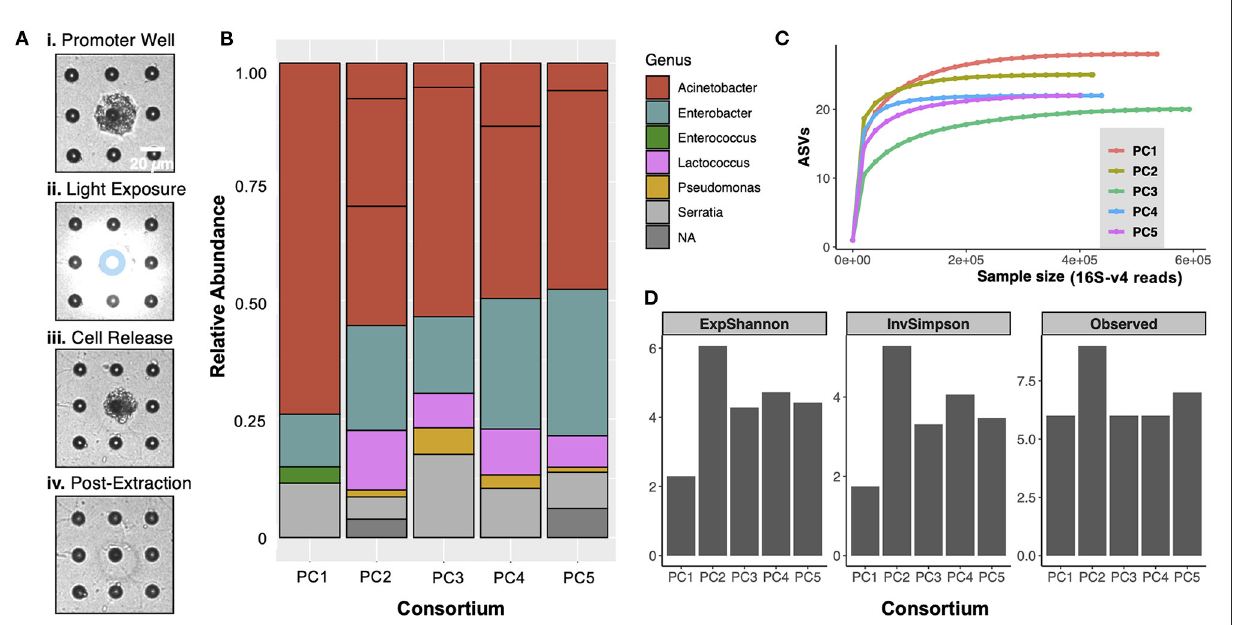
FIGURE3 (A) Removal of communities from promoter wells. The perimeter of the promoter well was exposed to UV light in a 10 µ m inner diameter and 20 µ m outer diameter ring pattern (denoted by blue ring in (ii)) to open the photodegradable membrane above the well while also minimizing direct UV exposure to cells. After membrane degradation, cells were released from only the opened well. (B) Taxonomic bar plots of the composition of the 5 promoter consortia (PC1-PC5), extracted from promoter wells. ‘NA’ indicates reads that were not assigned to one of the dominant genera. (C) Rarefaction curves generated prior to removal of rare ASVs indicate that the sequencing effort was sufficient to capture the full diversity of each promoter consortium. (D) Alpha diversity metrics are presented for the 5 promoter consortia. “ExpShannon” = Shannon diversity, calculated as e [Shannon index] . “InvSimpson” = Inverse Simpson diversity. “Observed” = number of